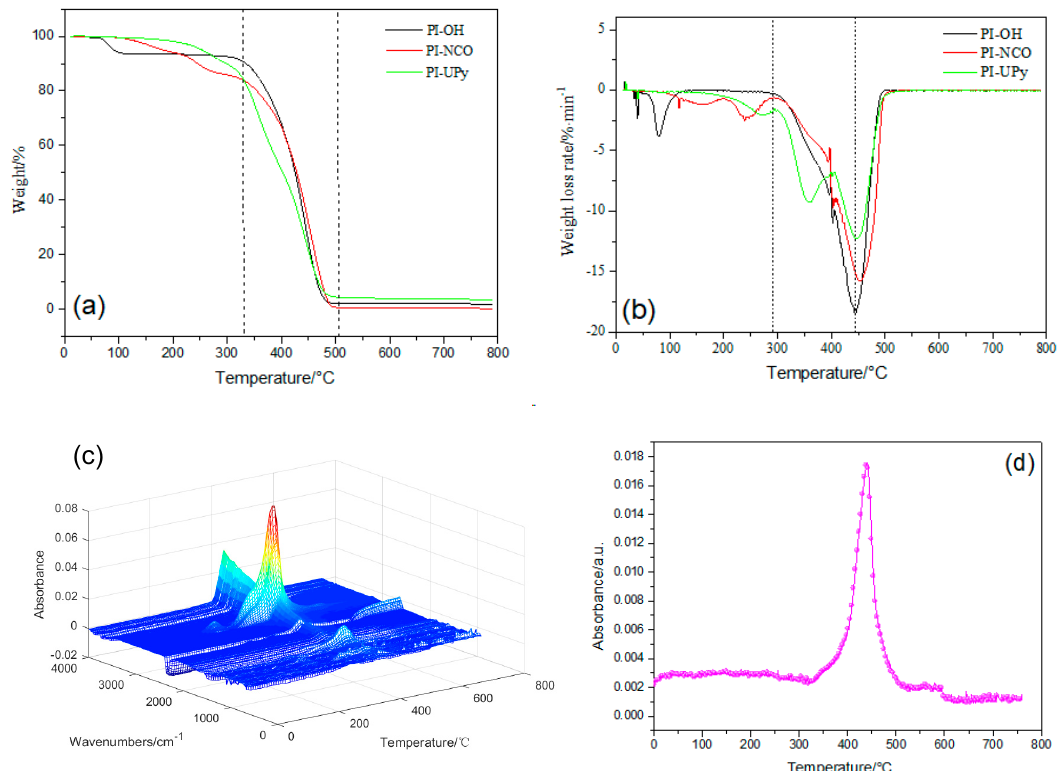
Figure 6. Thermogravimetric analysis (TGA) ( a ) and DTG ( b ) of PI-OH, PI-NCO, and PI-UPy; ( c , d ) TGA infrared (TGA-IR) data for PI-UPy.